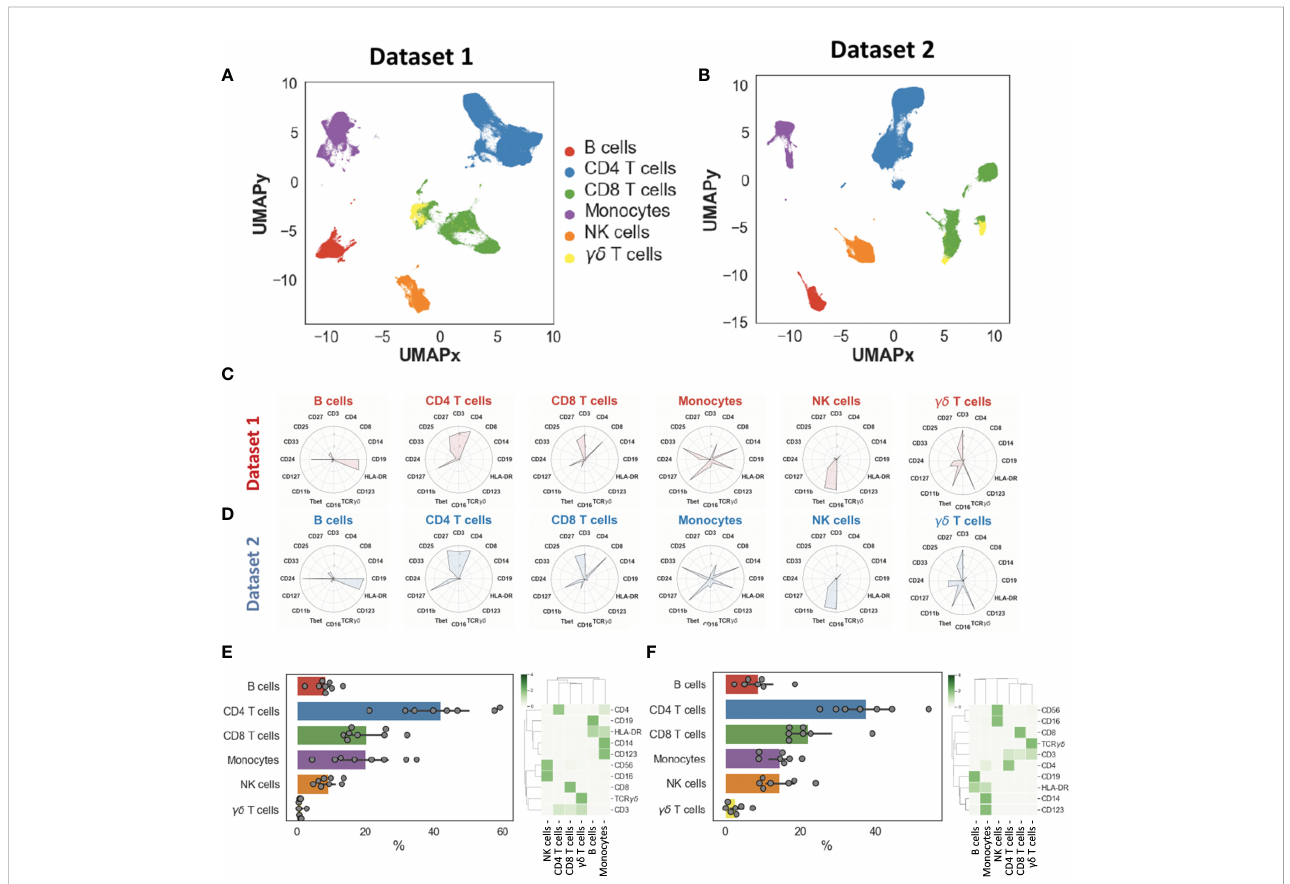
FIGURE 1 Landscape of major immune cell populations. Dimensionality reduction (UMAP) and annotation of main populations in datasets 1 and 2 (A – B) . Mean metal intensities used to identify the main populations for datasets 1 and 2 (C – D) . Population percentages and heatmaps illustrating main population phenotypes in datasets 1 (E) and dataset 2 (F)